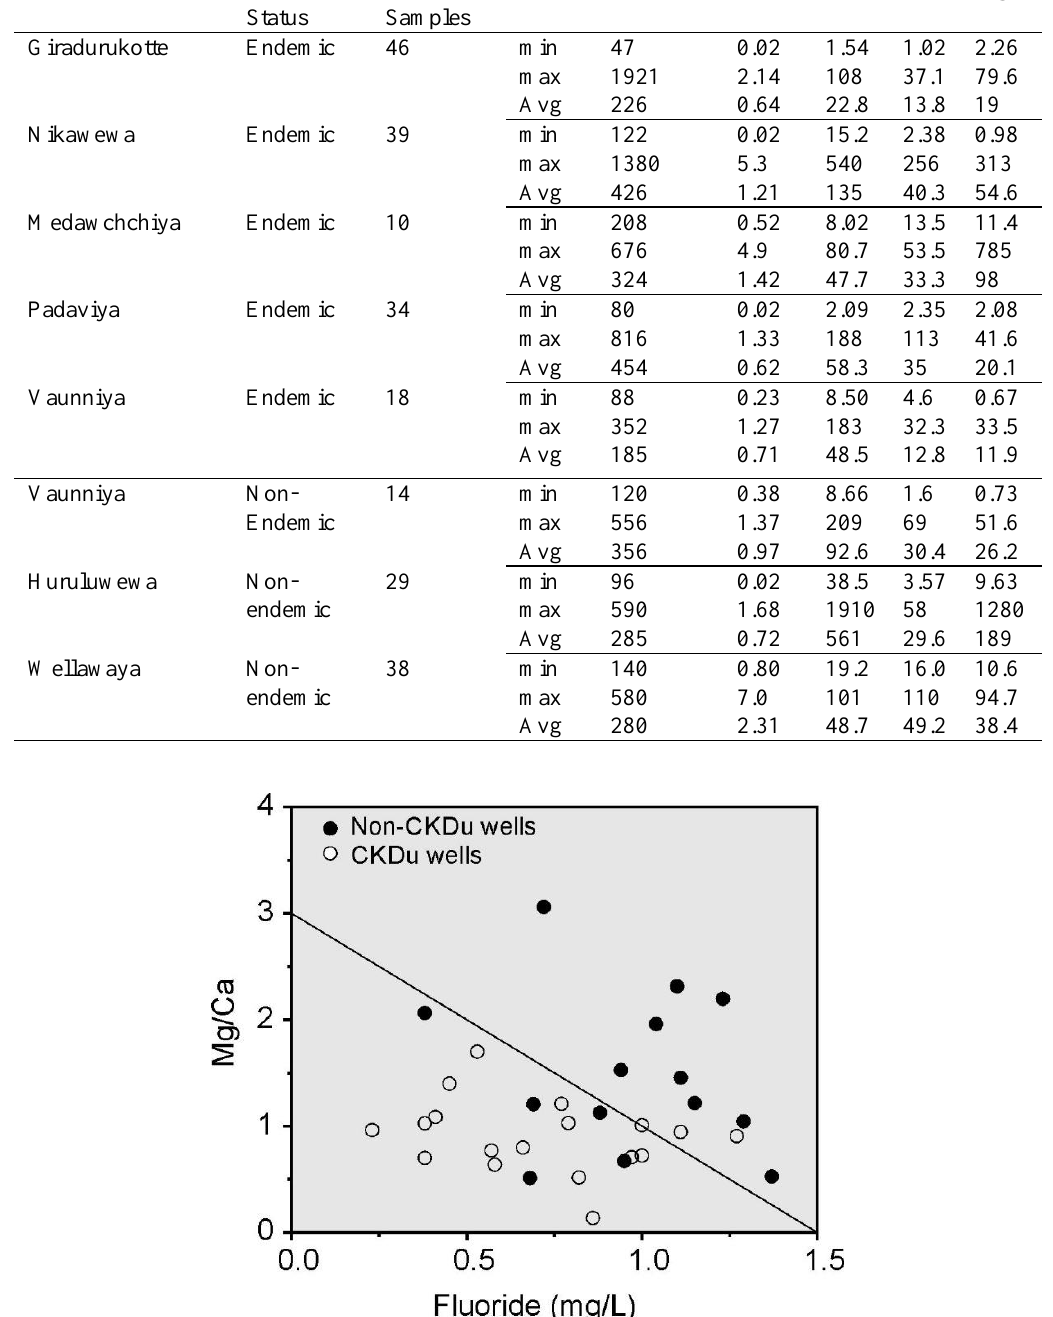
Figure 4: Discrimination between fluoride and Mg2+/Ca2+ ratio in drinking water wells used by CKDu and non-CKDu people in Vavuniya, Sri